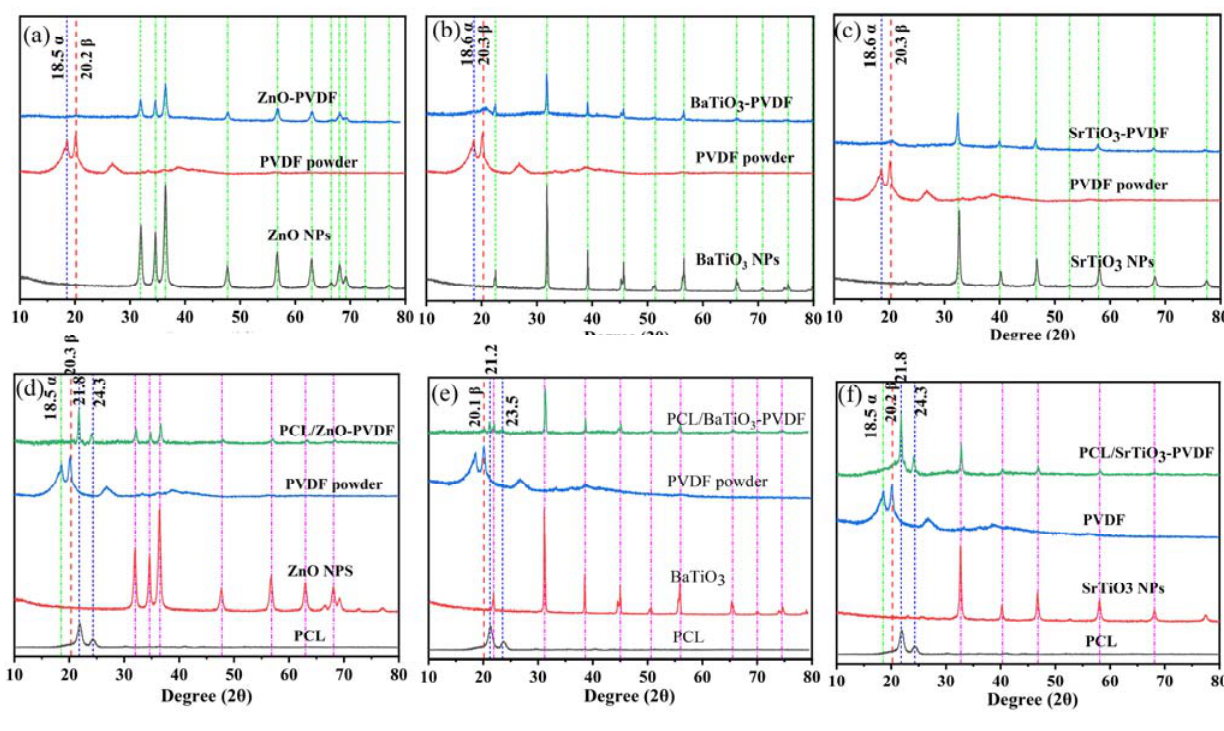
Figure 6. XRD spectra of ( a ) ZnO-PVDF, ( b ) BaTiO 3 -PVDF, ( c ) SrTiO 3 -PVDF, ( d ) PCL/ZnO-PVDF, ( e ) PCL/BaTiO 3 -PVDF, and ( f ) PCL/SrTiO 3 -PVDF.